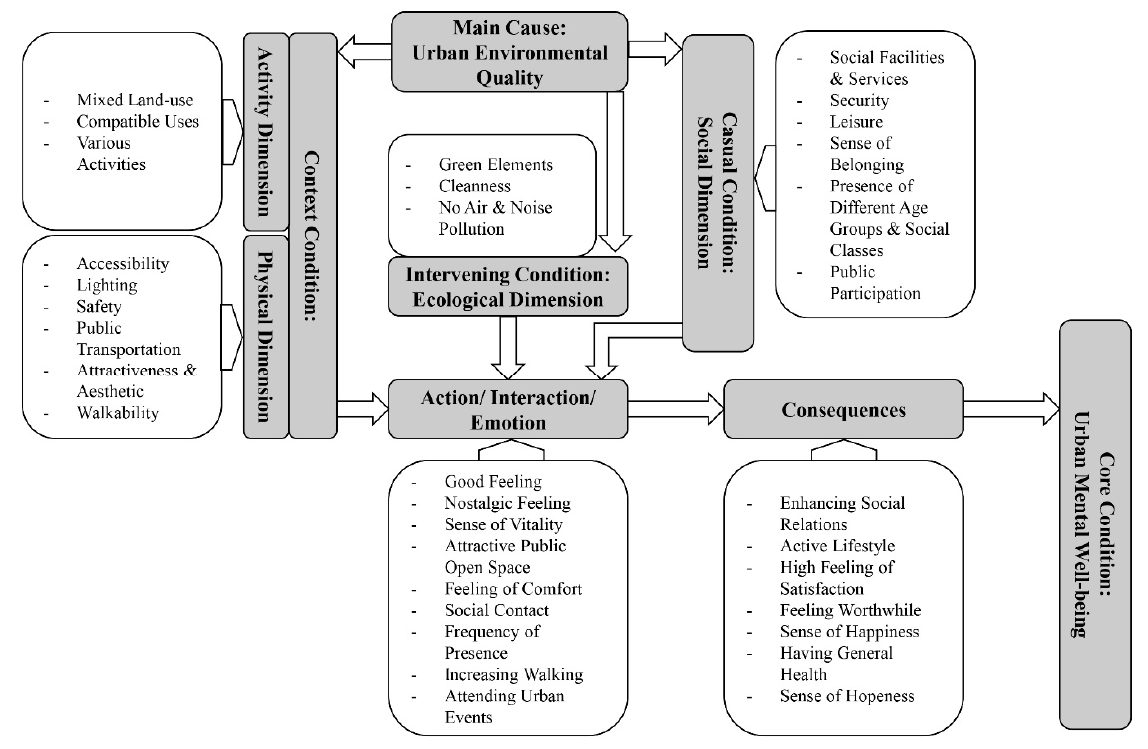
Figure 3. The final model of how the environmental quality of public open spaces affects the users’ mental well-being.